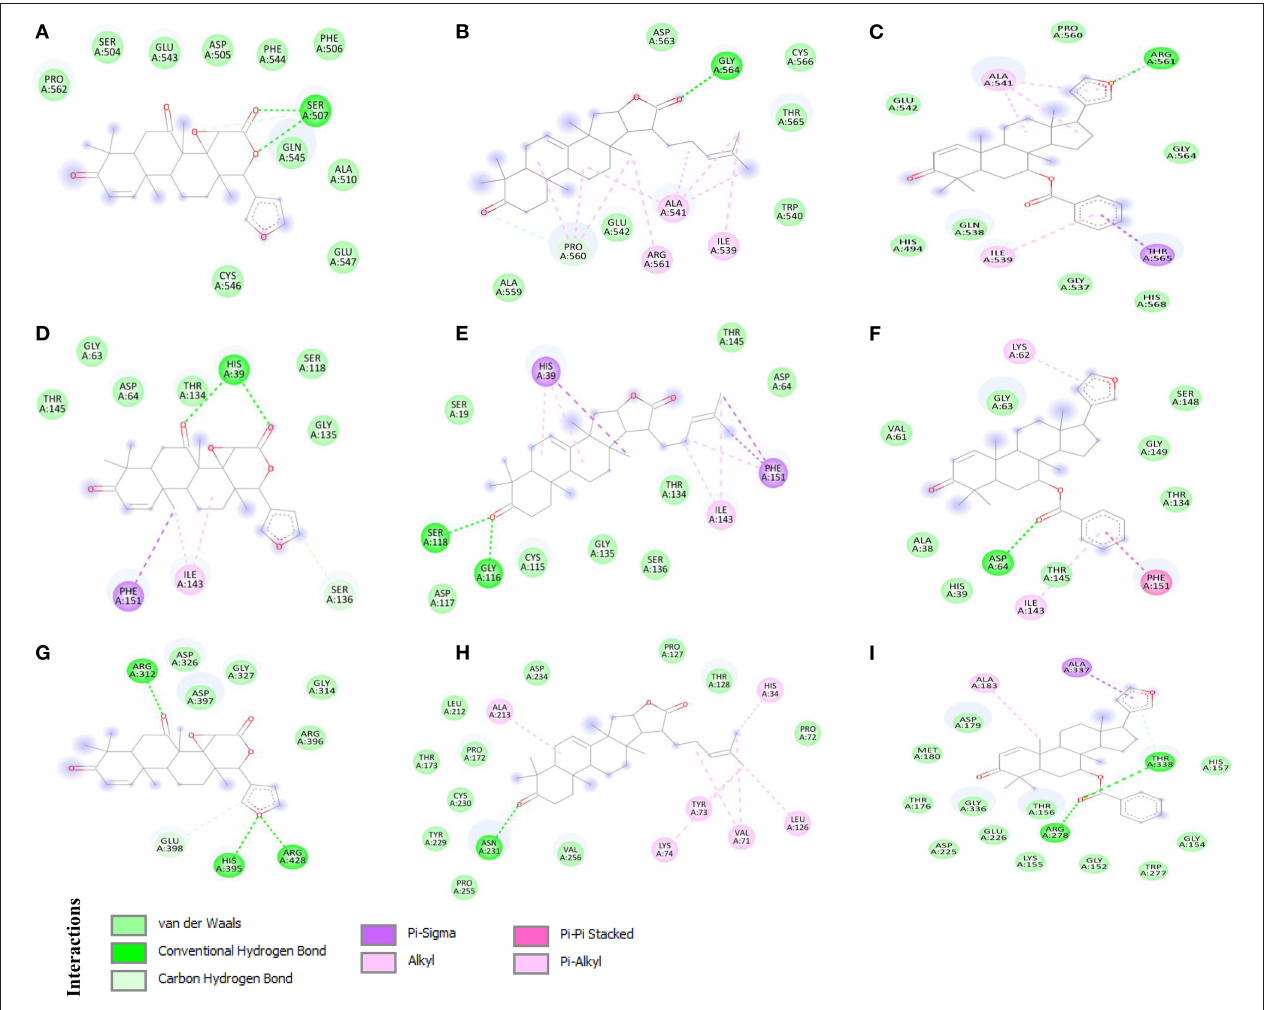
FIGURE 2 | 2D representation of the identified multi-target protein-ligand complexes and key amino acid residues contributing to the interactions. (A) CD163 scavenger receptor cysteine-rich domain 5 (CD163-SRCR5)-CID:1886, (B) CD163-SRCR5-CID:15560423, (C) CD163-SRCR5-CASID:104522-76-1, (D) Nsp4-CID:1886, (E) Nsp4-CID:15560423, (F) Nsp4-CASID:104522-76-1, (G) Nsp10-CID:1886, (H) Nsp10-CID:15560423, and (I) Nsp10-CASID:104522-76-1.